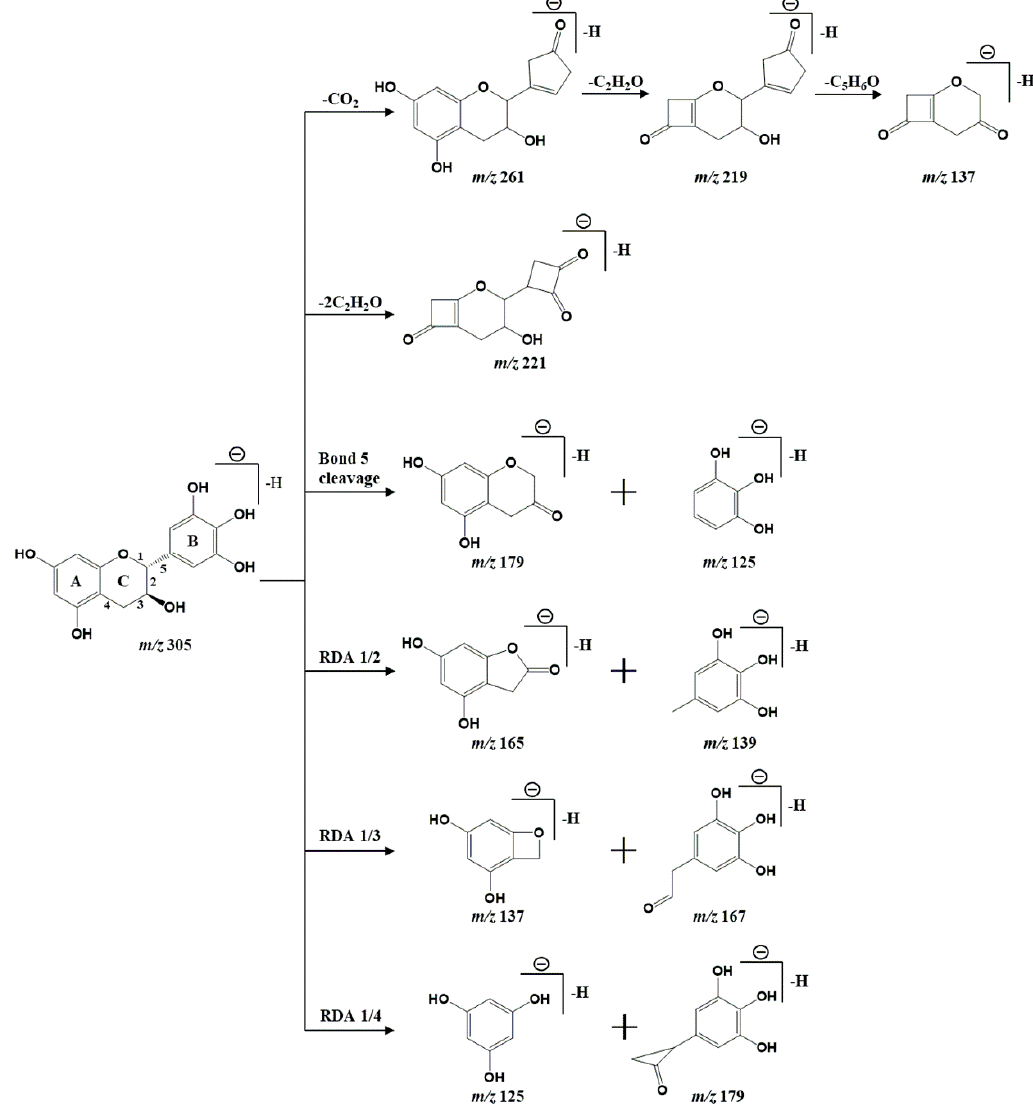
Figure 3. Proposed fragmentation scheme of deprotonated gallocatechin.